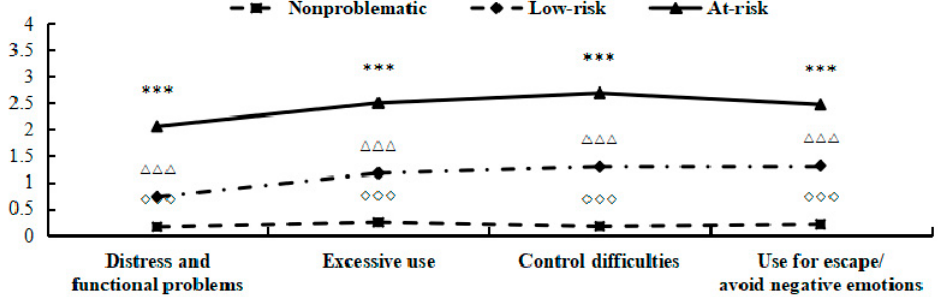
Figure A2. The average scores of the three latent classes based on the dimensions of PPUS. Note: PPUS = Problematic Pornography Use Scale, range = 0–5.